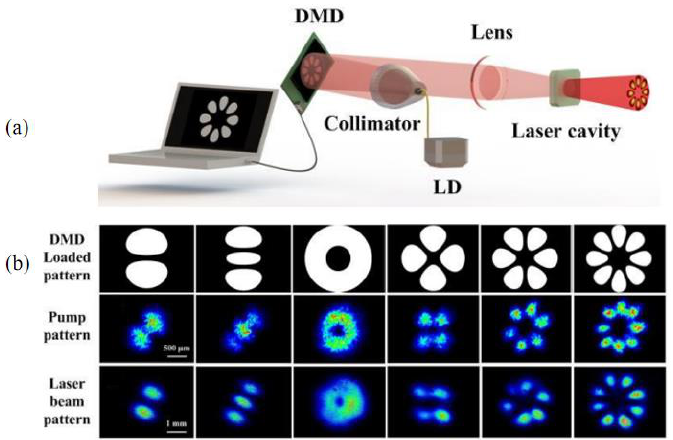
Figure 7. ( a ) Schematic of the structured light laser using DMD; ( b ) The DMD loaded patterns, the corresponding pump beam profiles, and the output beam patterns in laser cavity (Adapted from an open-access source Ref. [75]).